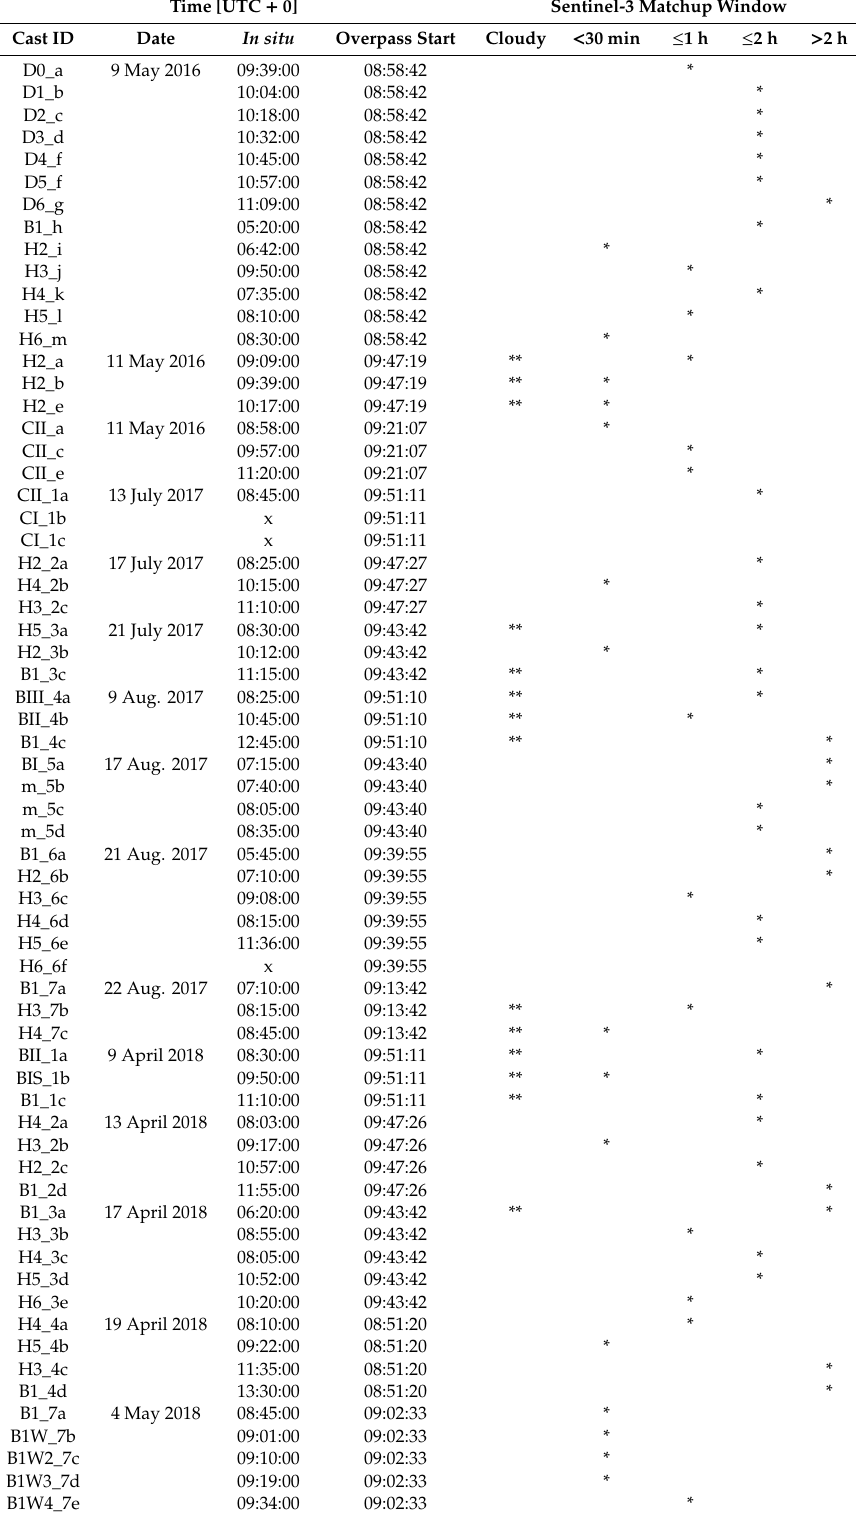
Table 2. List of optical stations during Sentinel-3A OLCI validation campaigns 2016–2018 in the NW Baltic proper. * Indicates the time lag between the in situ sampling and the S3 overpass. ** Indicates that the match-up station was under